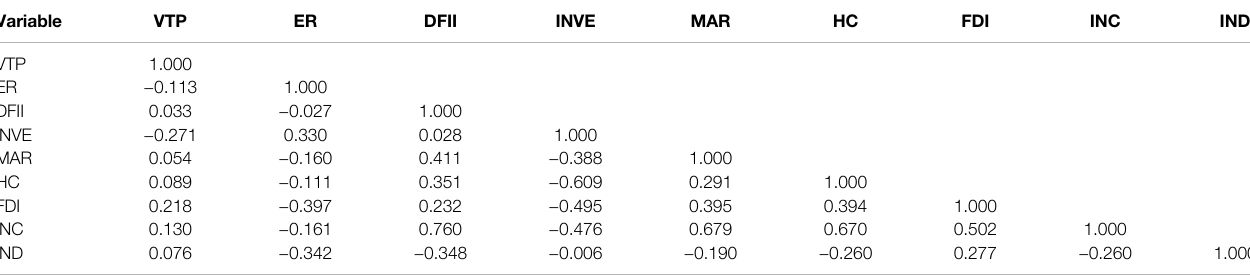
TABLE 4 | Results of correlation test.